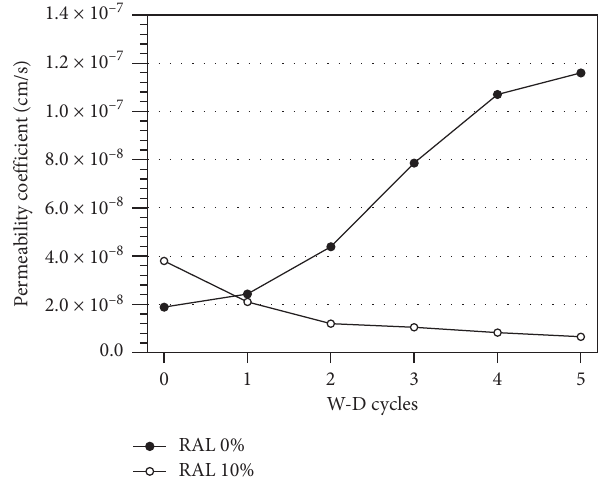
Figure 7: Variations in the permeability coefficients of the un- treated and lime-stabilized specimens (10% RAL) with the W-D